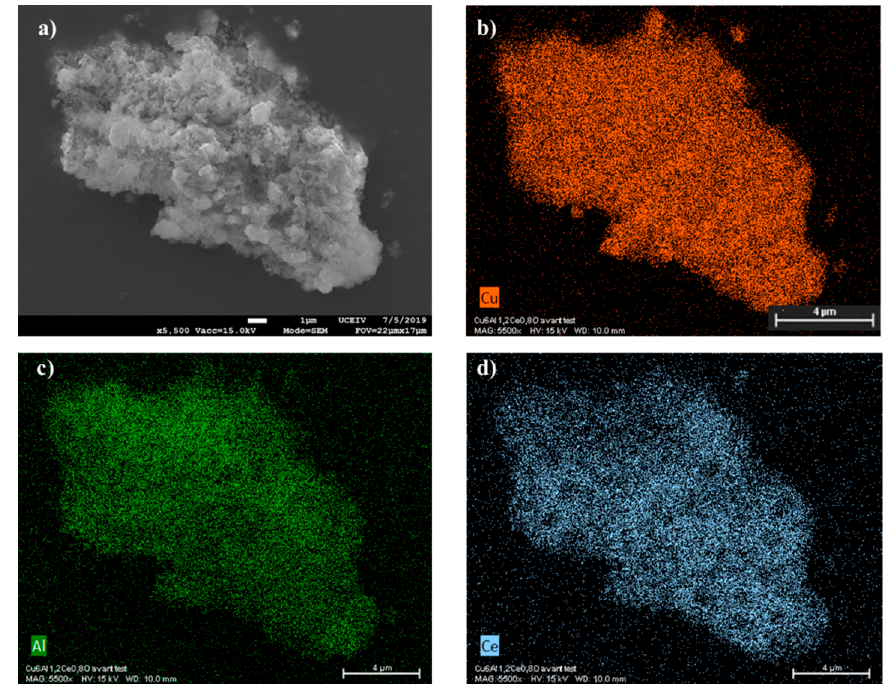
Figure 4. SEM images and element mapping of Cu 6 Al 1.2 Ce 0.8 -O sample.